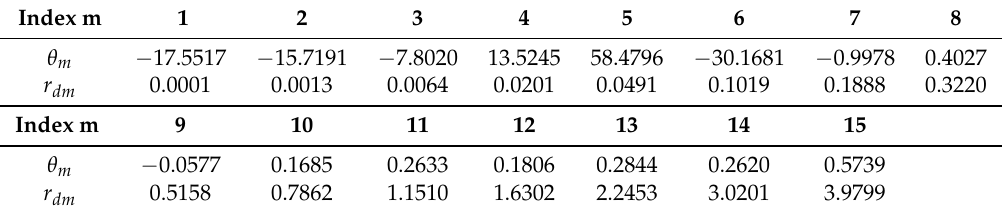
Table 2. The identified weighting vectors of the dead-zone (DZ) model.